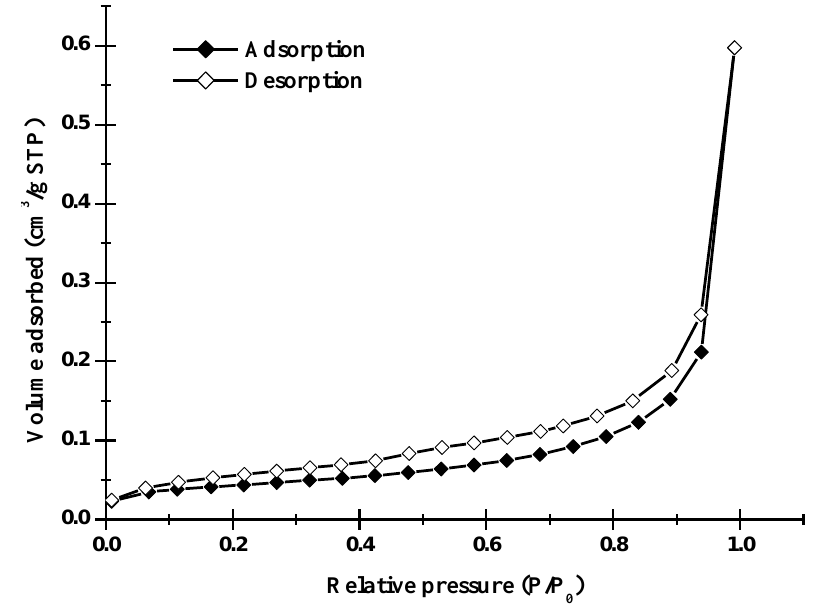
Figure 3. Pore size distribution of the optimal calcite-based powder ( i.e. ,